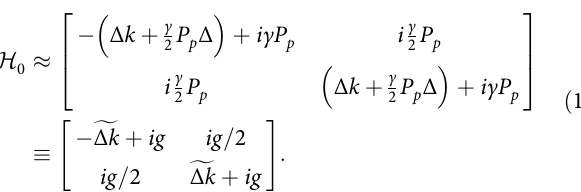
Here, γ is the SBS gain coef fi cient in units of W − 1 × m − 1 and Δ ≡ 2(2 π · Δ v )/ Γ B is the normalized detuning between probe tones. The Hamiltonian includes SBS ampli fi cation of each γ probe tone ig (cid:5) i γ P , the coupling between probes ig = 2 (cid:5) i P , p p 2 f Δ γ Δ Þ , which is and the total wavenumber mismatch k (cid:5) ð Δ k þ P p 2 the sum of Δ k and the additional contribution stemming from complex-valued Brillouin gain induced by the two off- resonant acoustic waves. Equation (1) is valid under the slowly varying envelope approximation and neglects linear losses, which are much smaller than the Brillouin gain in our setup.